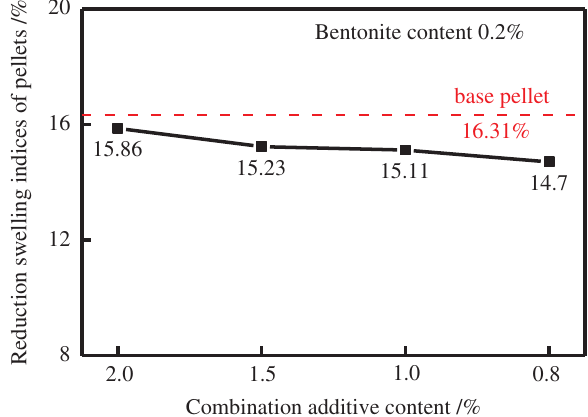
Figure 8: Effects of combination additive on reduction swelling indices of